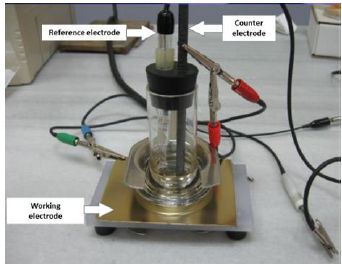
Figure 4. Experimental set-up used for electrochemical characterisation of samples.